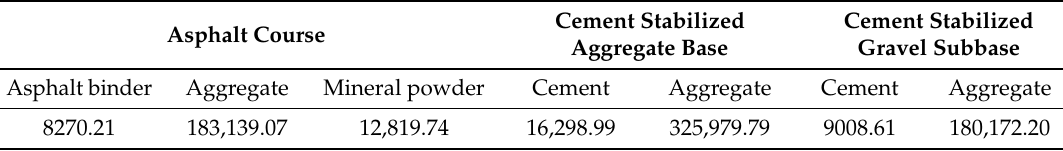
Table 1. Mass of raw materials in pavement structure (units: t).